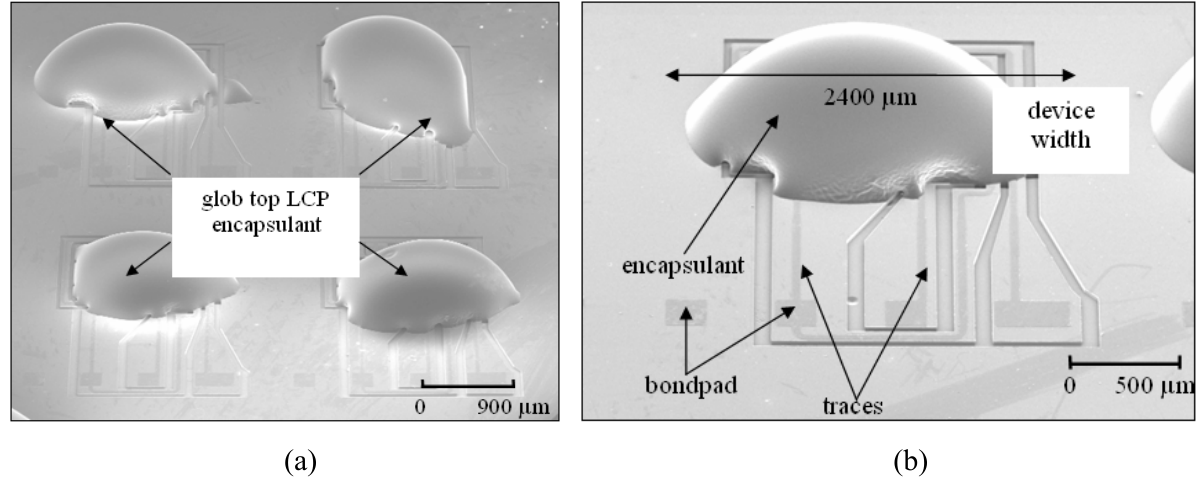
Table 3. Load-depth correlation and other mechanical properties of the cured RTP 3485-1 LCP outer